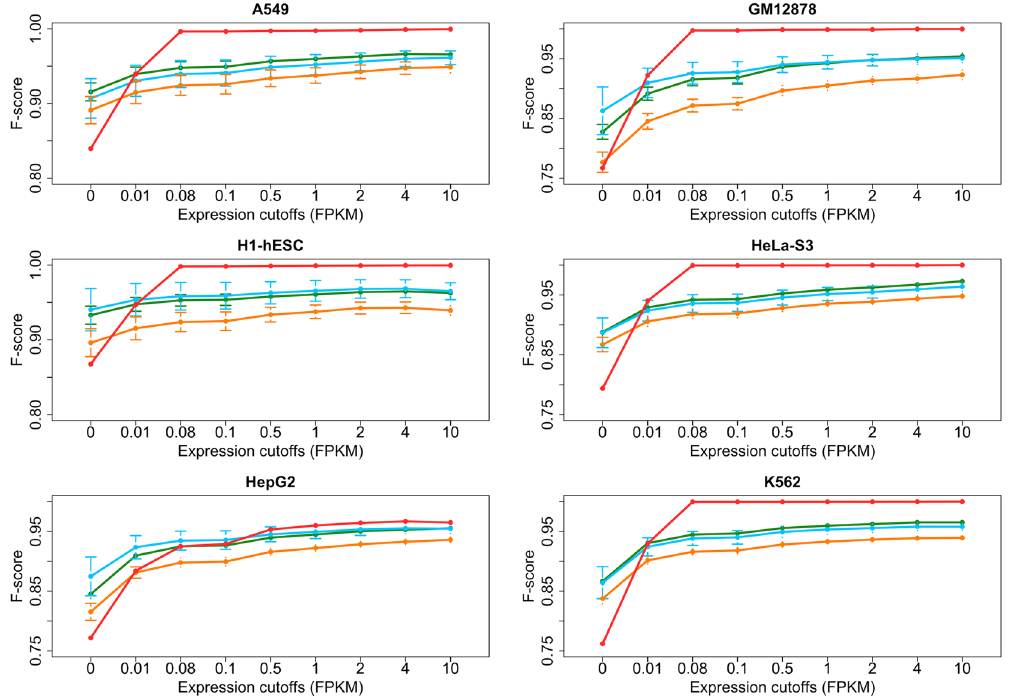
Figure 1. F -Scores after applying FPKM expression cutoffs in each gold standard dataset. Comparison of F 1 1 -scores after applying lower expression cutoffs in all six gold standard datasets of our predictions (red line), F-Seq (blue line), MACS (orange line) and Hotspot (green line). Dots, exemplifying mean values, and confidence intervals are shown, representing F -scores across replicates and FDR (z-score) cutoffs. Only genes 1 that are more expressed than the cutoff were taken into account for the calculation of F -scores (0 cutoff 1 representing all genes). While our method shows on average 0.075 lower scores for the whole dataset, the performance increases when only non-expressed genes are omitted and gradually increases to 0.99 in all cases except